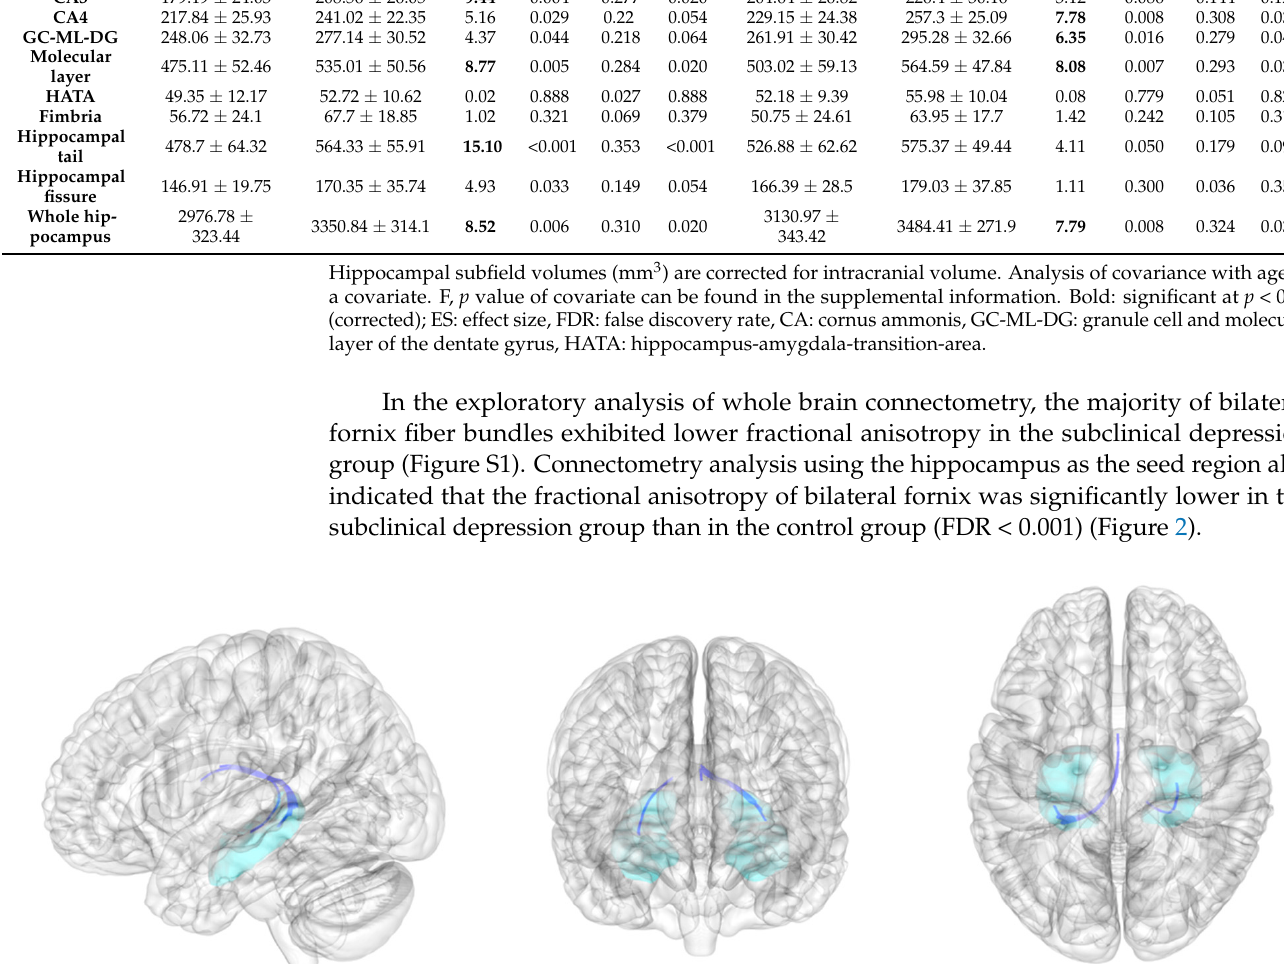
Figure 2. Group connectometry analysis. The blue indicates the fiber bundles exhibiting significantly decreased fractional anisotropy in the subclinical depression group when compared with that in the control group after correction for multiple comparisons (false-discovery rate < 0.001). The fiber bundles are part of the bilateral fornix. The cyan shading indicates the hippocampus.